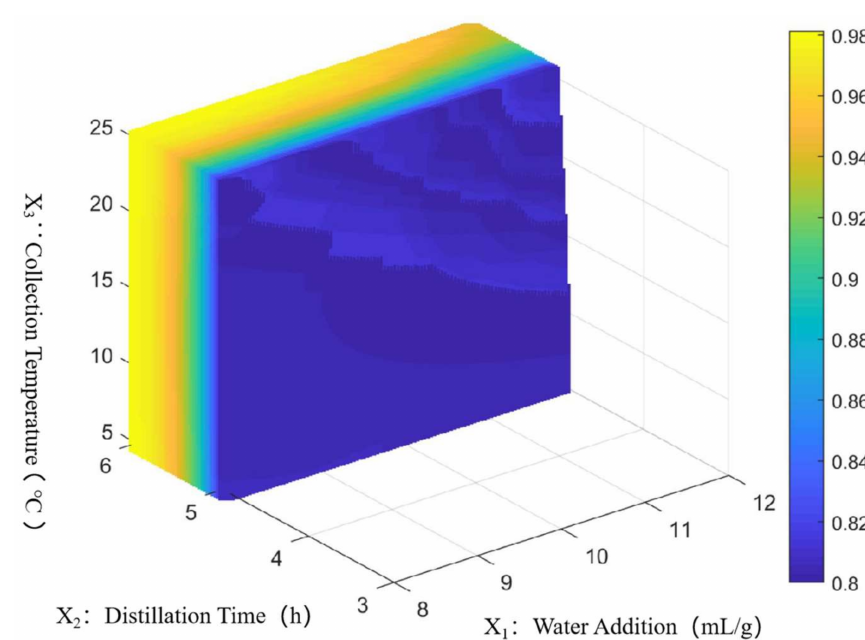
Figure 6. Three-dimensional design space